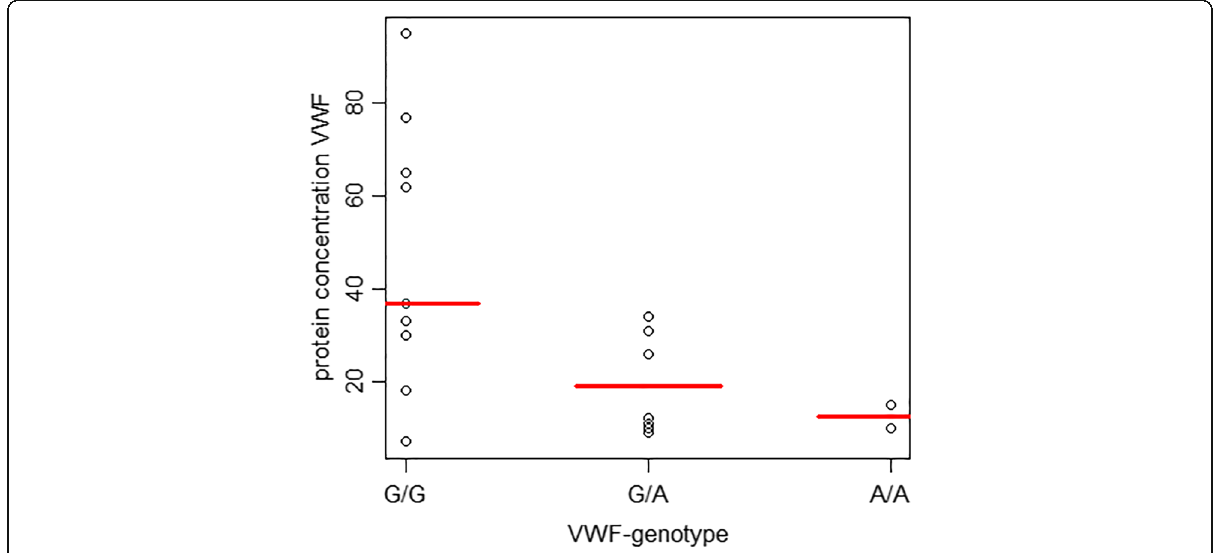
Fig. 4 Von Willebrand ’ s Factor protein concentration and genotype correlation in the Dutch Shepherd Dog. Correlation between Von Willebrand ’ s Factor protein concentrations in blood (median shown in red) and Von Willebrand ’ s Disease genotype (G/G=wildtype ( n =9), G/A=heterozygous carrier ( n =8), A/A =homozygous mutant ( n =2)), in 19 Dutch Shepherd Dogs. No significant difference in protein concentration was found when the three groups were compared (Kruskal-Wallis test, p =0.07). Comparing the wildtype group with the other two groups combined showed a significant difference in protein concentration (Mann-Whitney U test, p